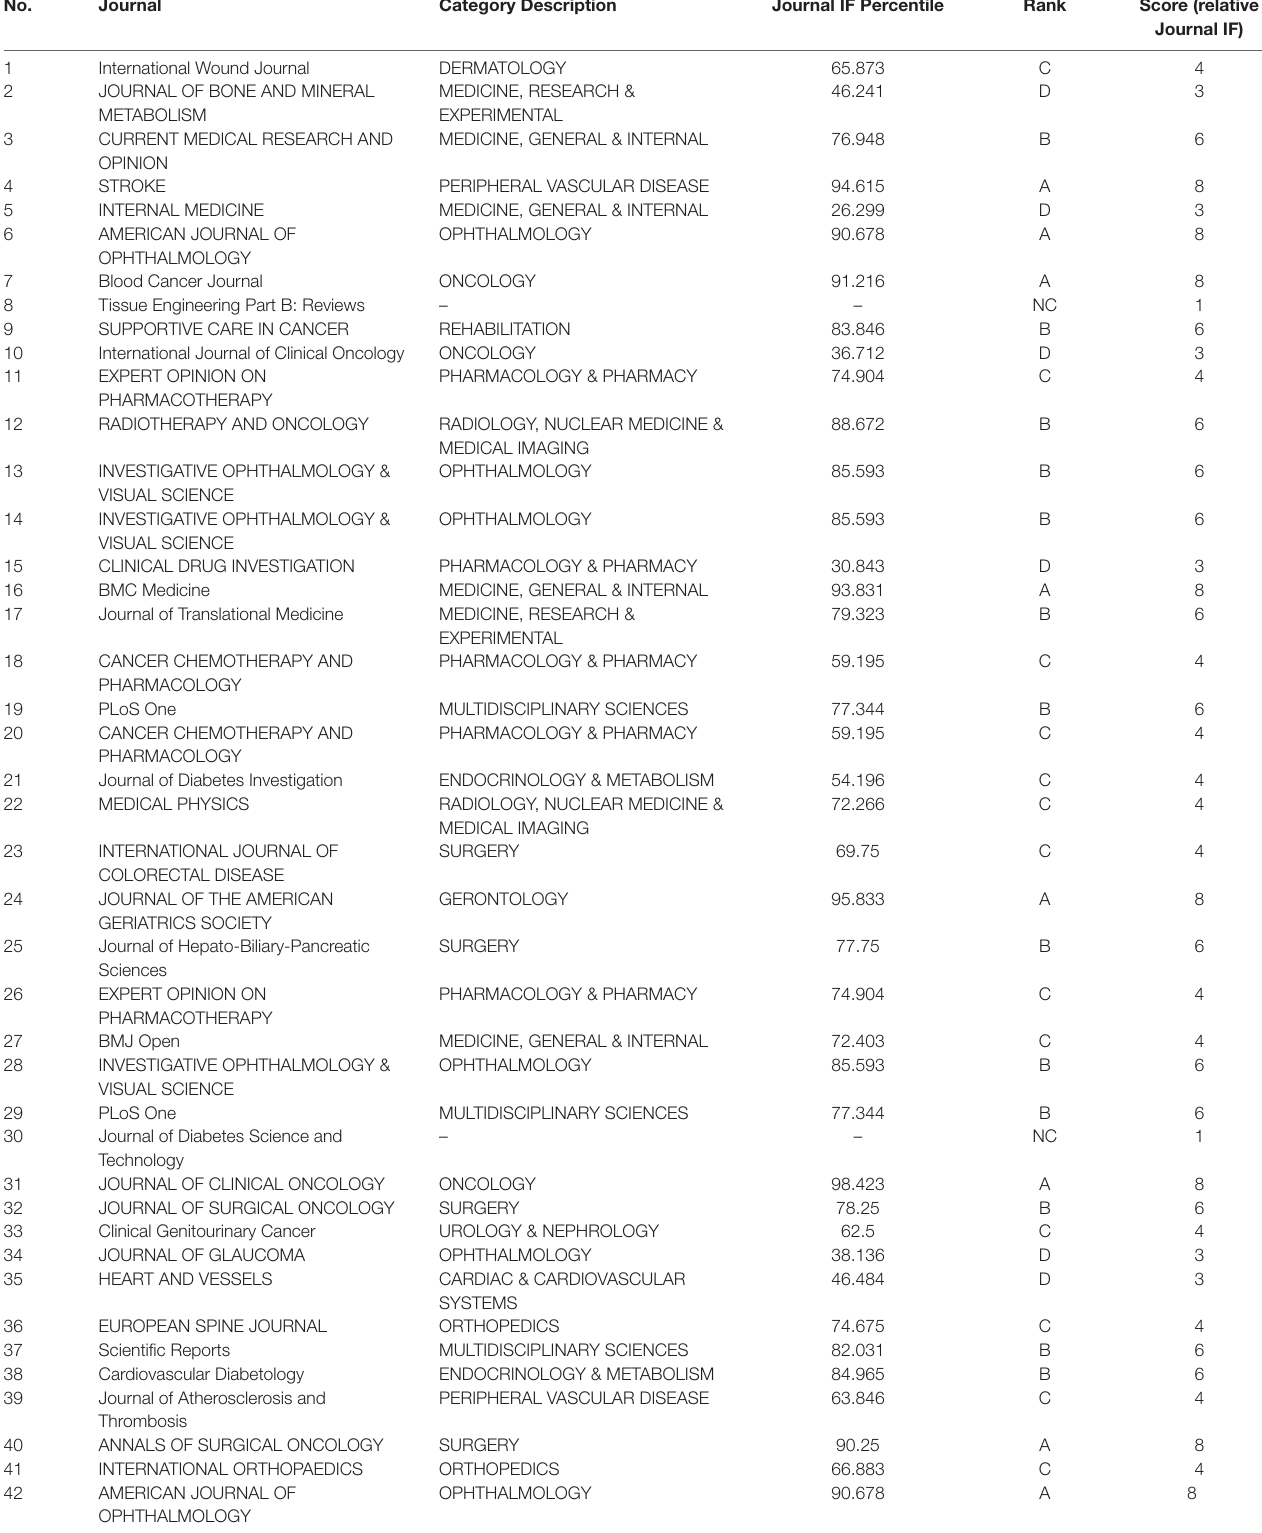
TABLE 2 | Example of relative Journal IF score calculated using the SIGAPS scoring system (Hospital D).